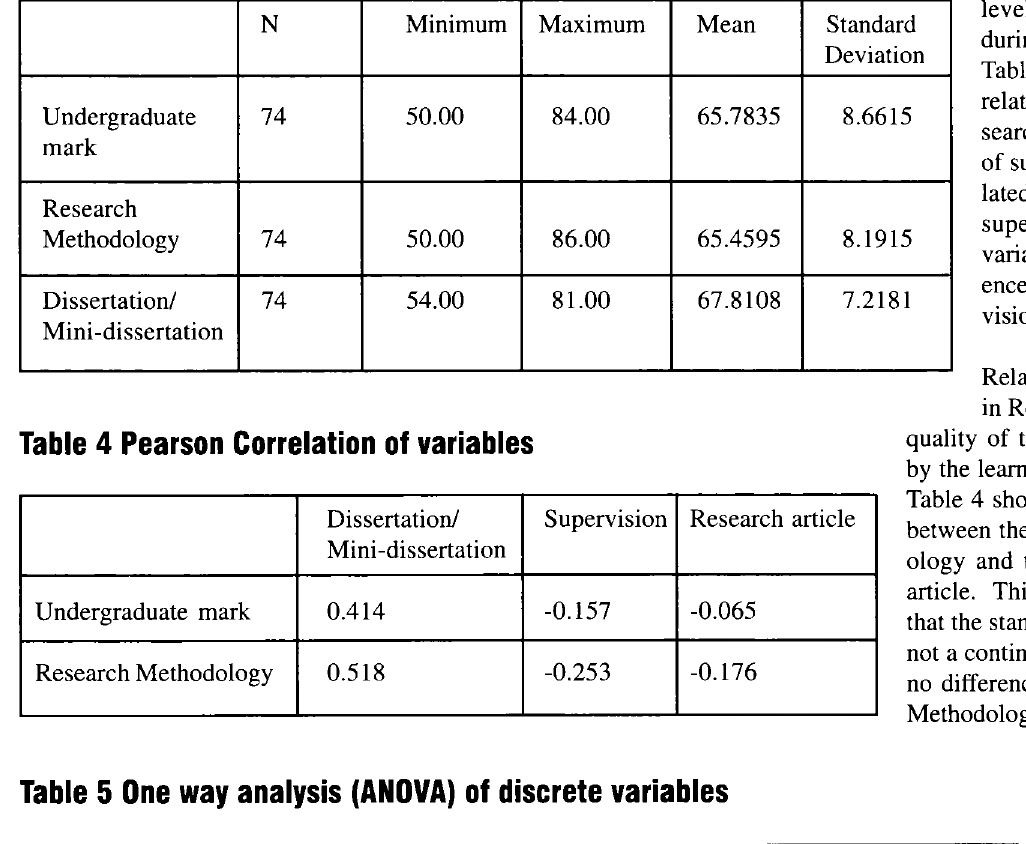
Table 6 Generalised Linear Model